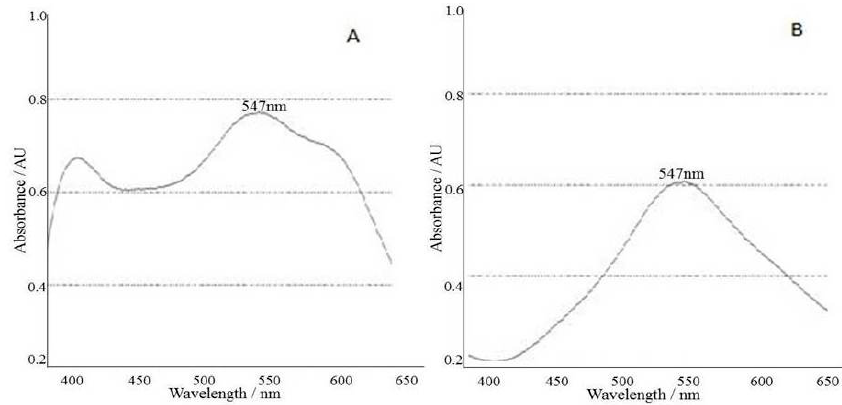
Figure 3. Standard calibration curve of ursolic acid standard solutions.